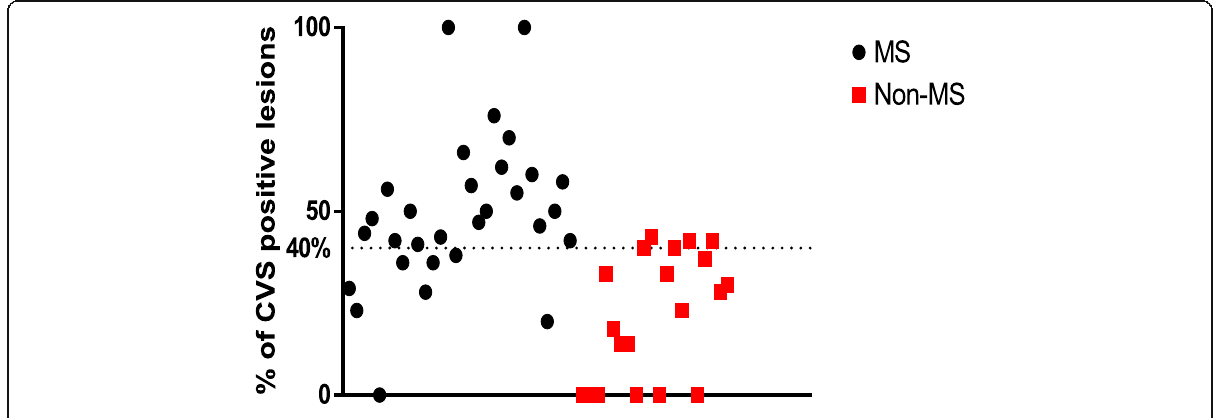
Fig. 3 Comparison of the proportion of peri-venous lesions seen in patients with MS versus patients with CSVD